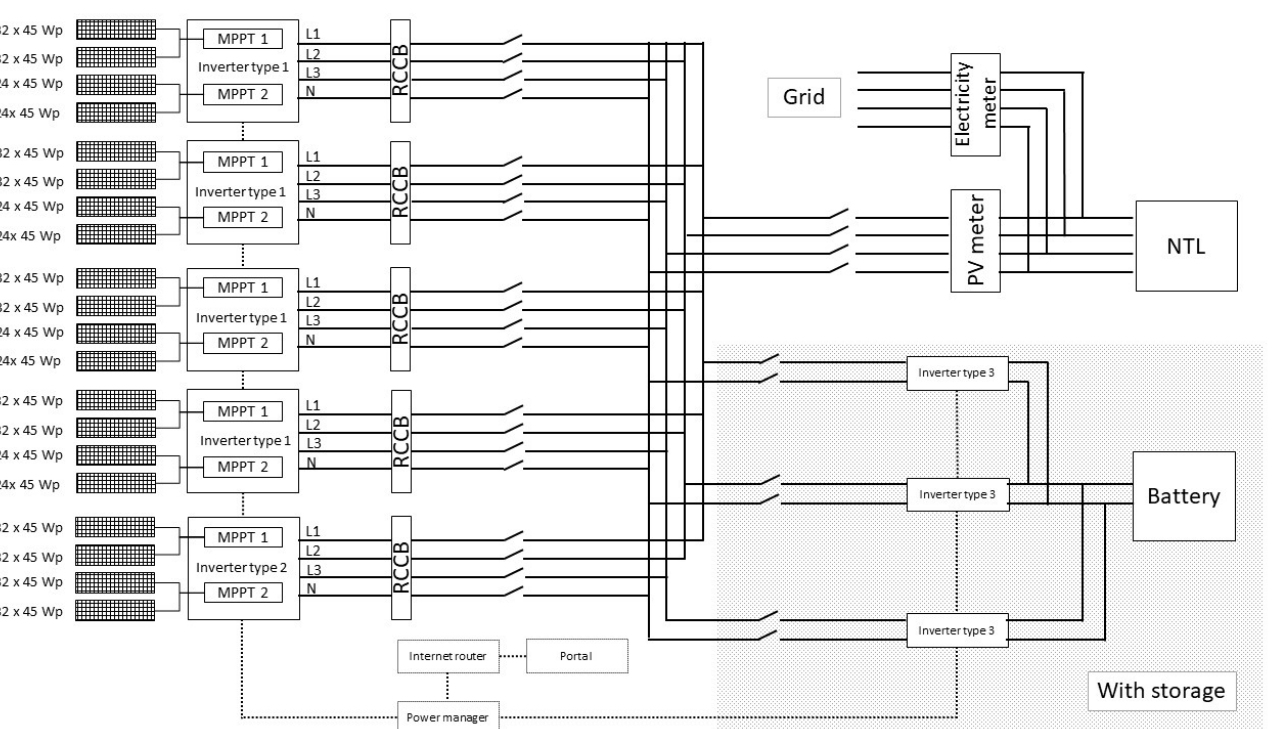
Figure 8. Electric integration of the Fresnel − PV